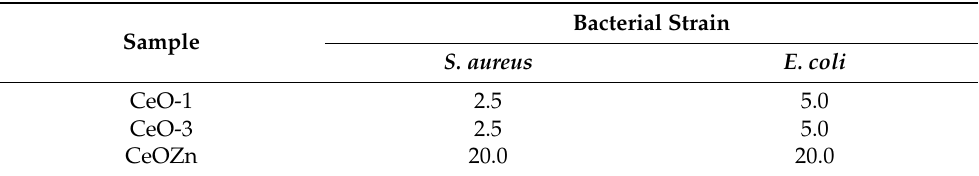
Table 5. Minimal inhibitory concentration (MIC) (mg/mL) of the cerium oxide nanoparticles against tested